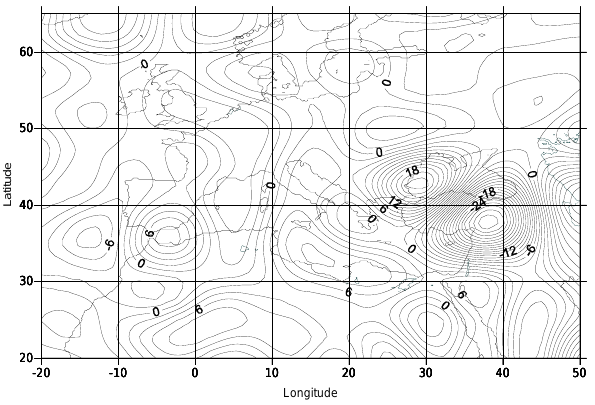
Fig. 5. The divergence of the horizontal wind vector over the 850hPa isobaric surface ( × 10 − 6 s − 1 ) for the cluster “North”, at time D0. (calculated, but not presented) is characterized by large di- vergence values. The combination of the fields of divergence over the two tropospheric layers resulted in enhanced up- drafts and clouds formation over the entire tropospheric col- umn of the area of interest.